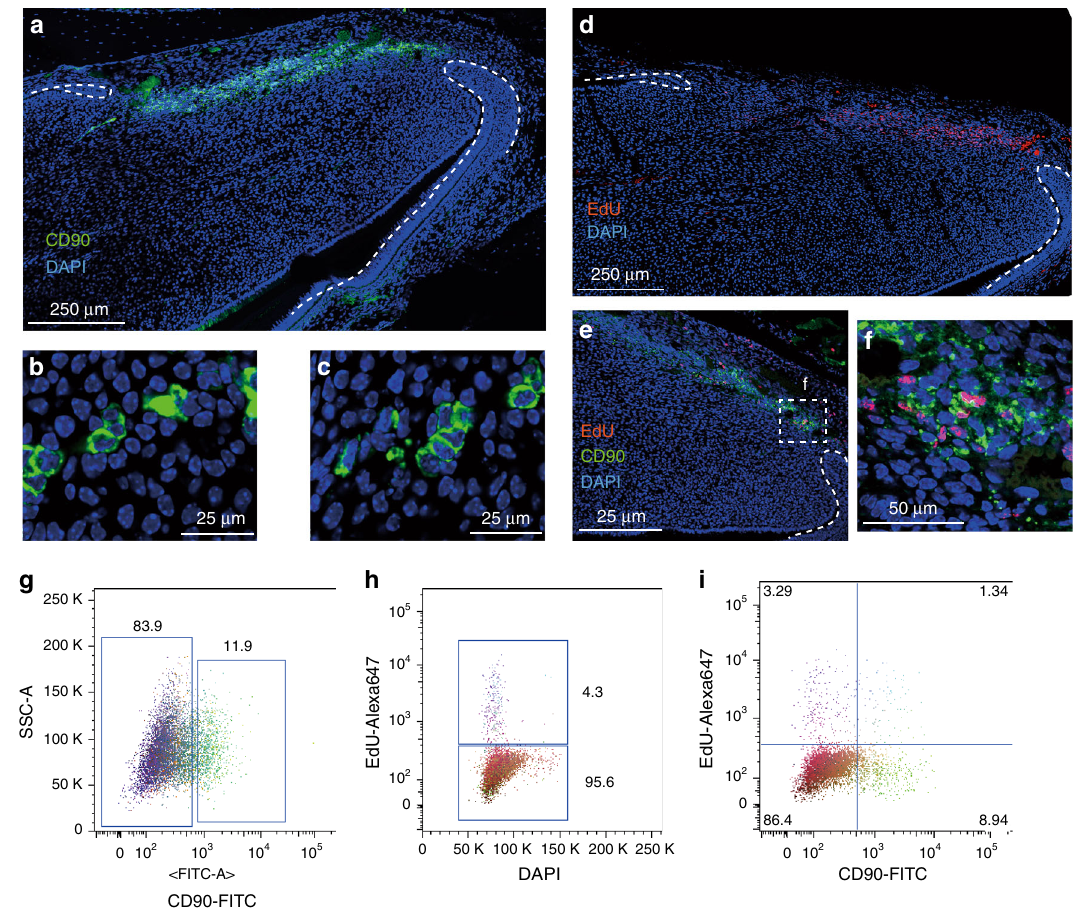
Fig. 1 CD90/Thy1 expression in small clusters of cells in the dental mesenchyme. a Immuno- fl uorescent staining shows CD90/Thy1 expression in the dental mesenchyme between the labial and lingual aspects of the cervical loop at the apical end of the mouse incisor on the sagittal section images. b , c High magni fi cation images show CD90/Thy1 is expressed in small clusters of cells. d Long-chase EdU retaining cells occupy a similar location between the two aspects of epithelial cervical loop. Mice were given EdU for four weeks and chased for another four weeks prior to tissue collection. e , f Co-staining of CD90/Thy1 and EdU demonstrates partially co-localization. g FACS analysis of CD90/Thy1 expression in the postnatal (PN5) mouse dental pulp tissue showing about 12% of pulp cells express CD90/Thy1. h , i Long-chase EdU retention assay shows 4.3% of slow cycling cells are present in the incisor pulp ( e ), and about 30% of these slow cycling cells express